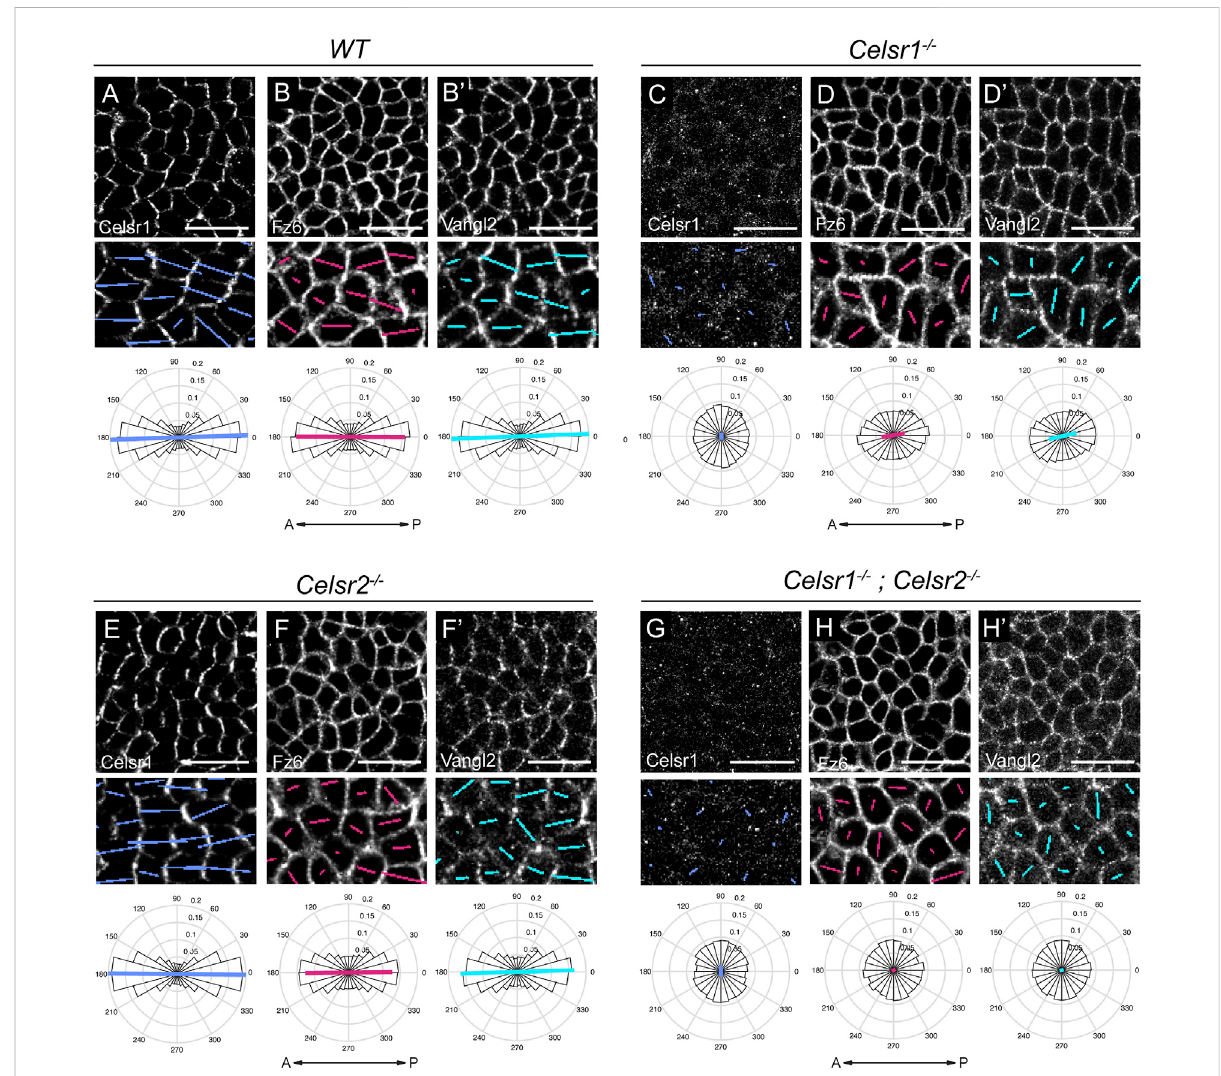
Loss of core PCP protein asymmetry in the epidermis of Celsr1 − / − and Celsr1 − / − ; Celsr2 − / − double mutants. (A – H) Representative planar views of thebasallayeroftheinterfollicularepidermisatE15.5showingCelsr1,Fz6andVangl2distributionasdetectedbyimmuno fl uorescence.Anterioristo the left. Scale bar: 20 µm. Magni fi ed areas below are overlaid with colored lines representing the axis (line angle) and magnitude (line length) of polarity. Quanti fi cation of polarity distributions are displayed below on circular histograms. (A-B 9 ) Celsr1 (A) , Fz6 (B) and Vangl2 (B ′ ) in WT embryos, n = 11,951 basal cells, 3 embryos. (C-D 9 ) Celsr1 (C) , Fz6 (D) , and Vangl2 (D ′ ) in Celsr1 − / − embryos, n = 11,629 basal cells, 3 embryos. (E-F 9 ) Celsr1 (E) , Fz6 (F) and Vangl2 (F ′ ) in Celsr2 − / − embryos, n = 12,099 basal cells, 3 embryos. (G-H 9 ) Celsr1 (G) , Fz6 (H) and Vangl2 (H ′ ) in Celsr1 − / − ; Celsr2 − / − embryos, n = 9,064 basal cells, 3